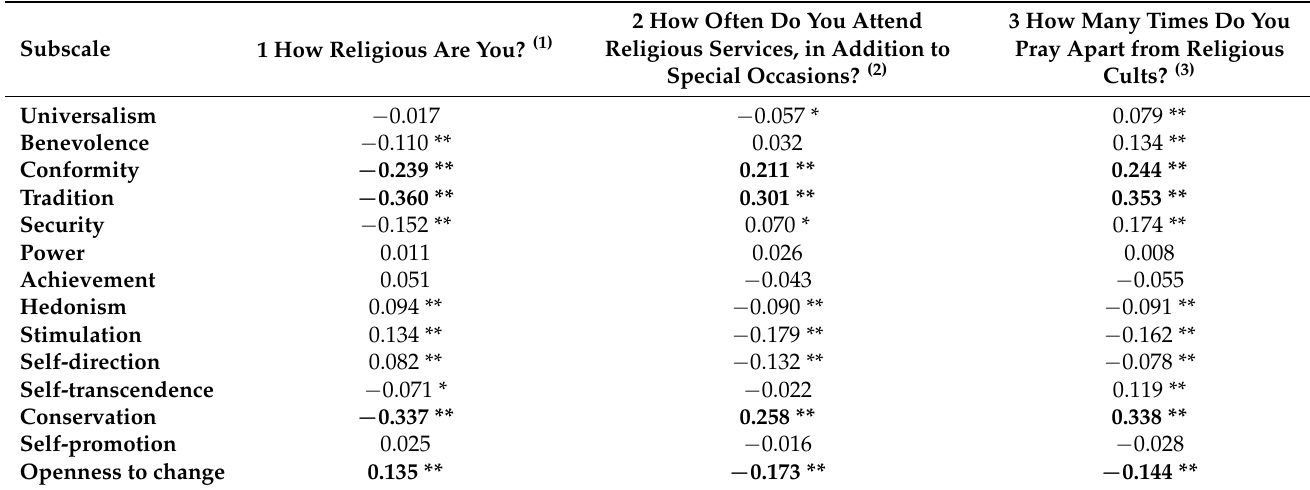
Table 4. Spearman rho correlations between religion, motivational values, and second-order